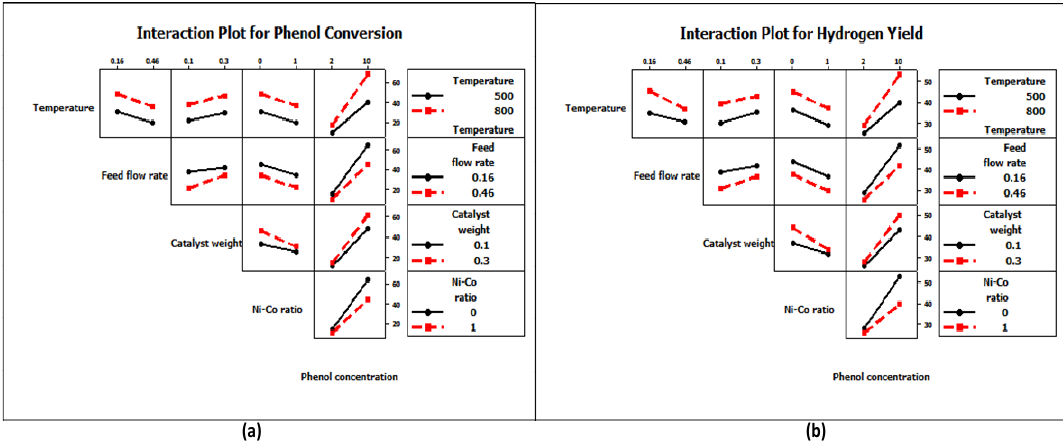
Figure 10. Full interaction plot matrix for ( a ) Y 1 and ( b ) Y 2 .